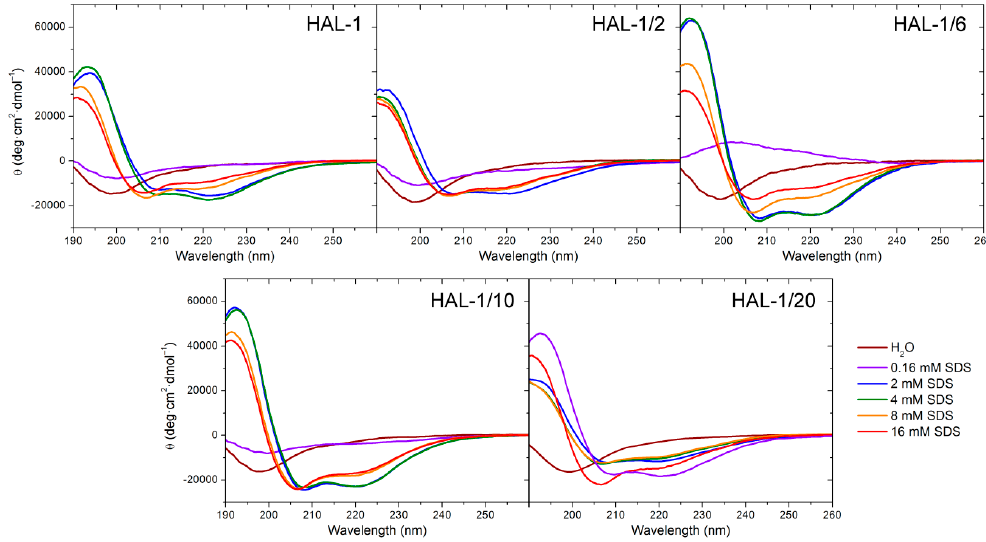
Figure 1. ECD spectra of HAL-1 and its analogs (0.125 mg/mL) in aqueous solution and in the presence of SDS (0.16, 2, 4, 8, and 16 mM). of SDS (0.16, 2, 4, 8, and 16